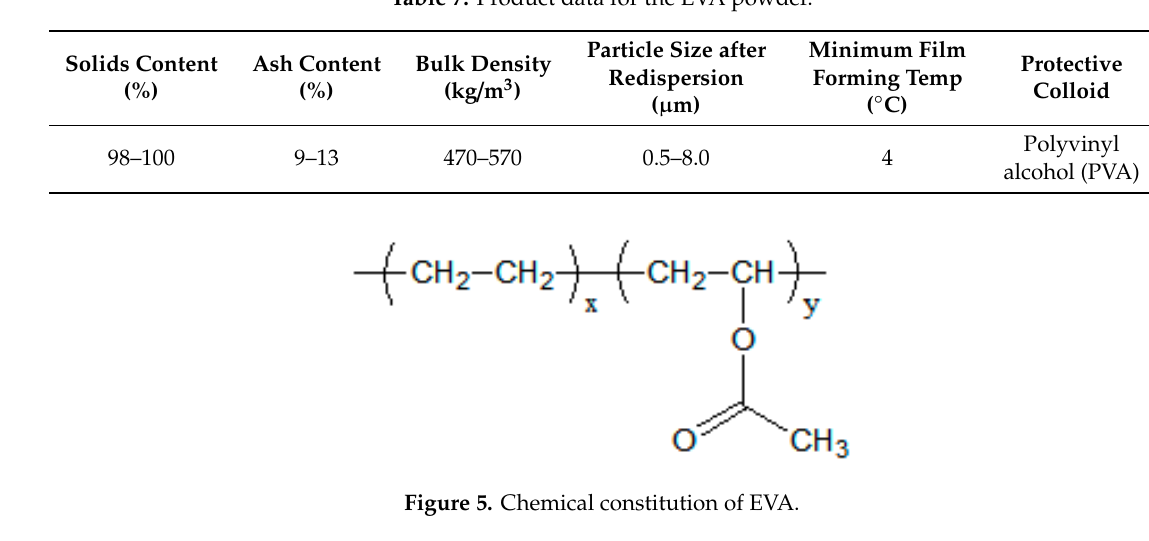
Table 7. Product data for the EVA powder.